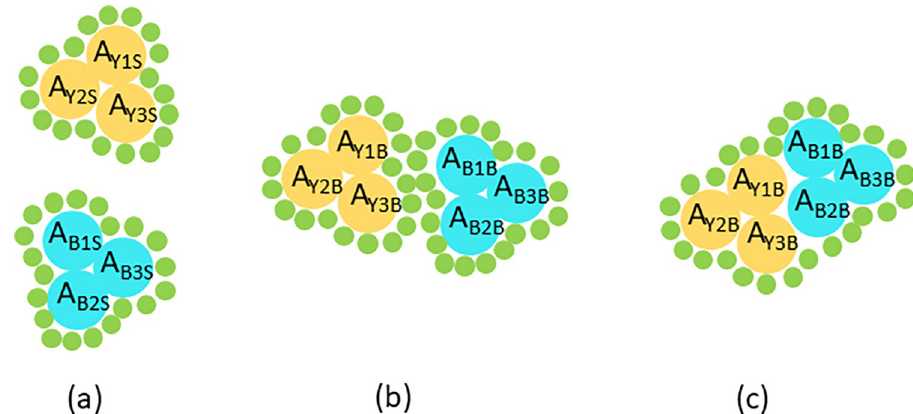
Fig 2. Schematic of the interaction calculation. Two elements are depicted here in yellow and blue with the individual circles representing the constituent residues. (a) The SASA of each residue is calculated for each element in isolation from the other elements in the ribosome. The three residues depicted here for each element are labeled by their color (B for Blue or Y for Yellow), an identifying number and an ‘S’ indicating that the SASA is calculated for a single element in isolation from all others in the ribosome. The additional radii due to a solvent molecule (green) of 1.4 Å located at its the surface is also indicated. (b) The SASA of two elements together and the solvent molecule is then calculated in the same way. Note that the final identifying label of the residues is ‘B’, indicating that the SASA is calculated for both elements together. The figure illustrates when an interaction is not present the difference in the SASA from the two individual elements is equal to that of the SASA when the two elements are both present. (c) Here an interaction is observed because although the area of residue A Y2S = A Y2B , for the other residues: A Y1S > A Y1B and A Y3S > A Y3B